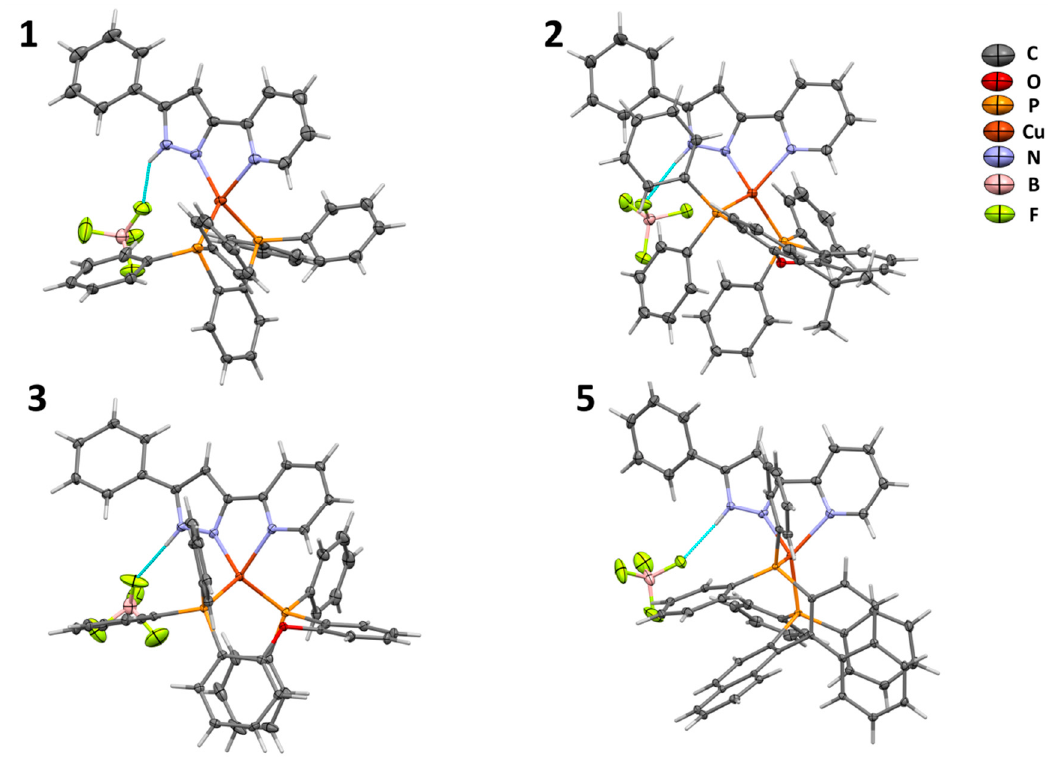
Figure 1. XRD structure of complexes 1 , 2 , 3 and 5 with thermal ellipsoids set at the 30% probability level.